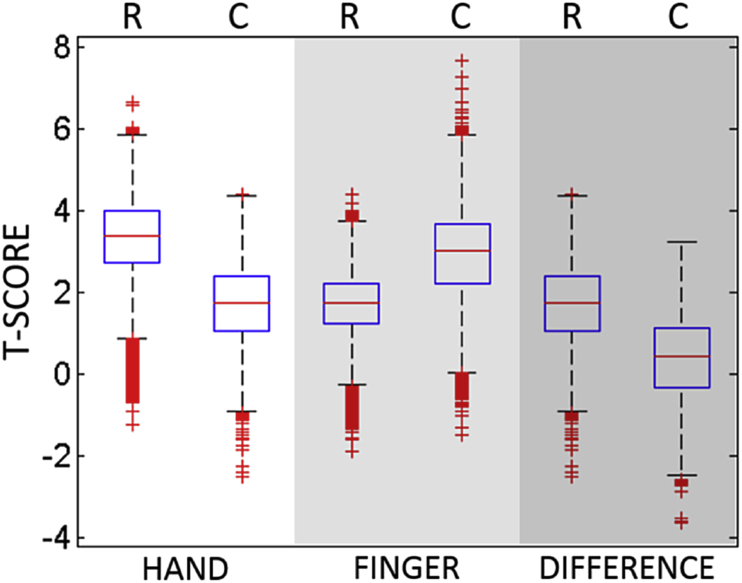
Boxplot of the T-statistics for the VLSM maps in analyses of hand and finger imitation deficits, and of the difference between them. Each analysis is associated with two boxplots, relating to maps generated from Raw (R), and Controlled (C) scores.